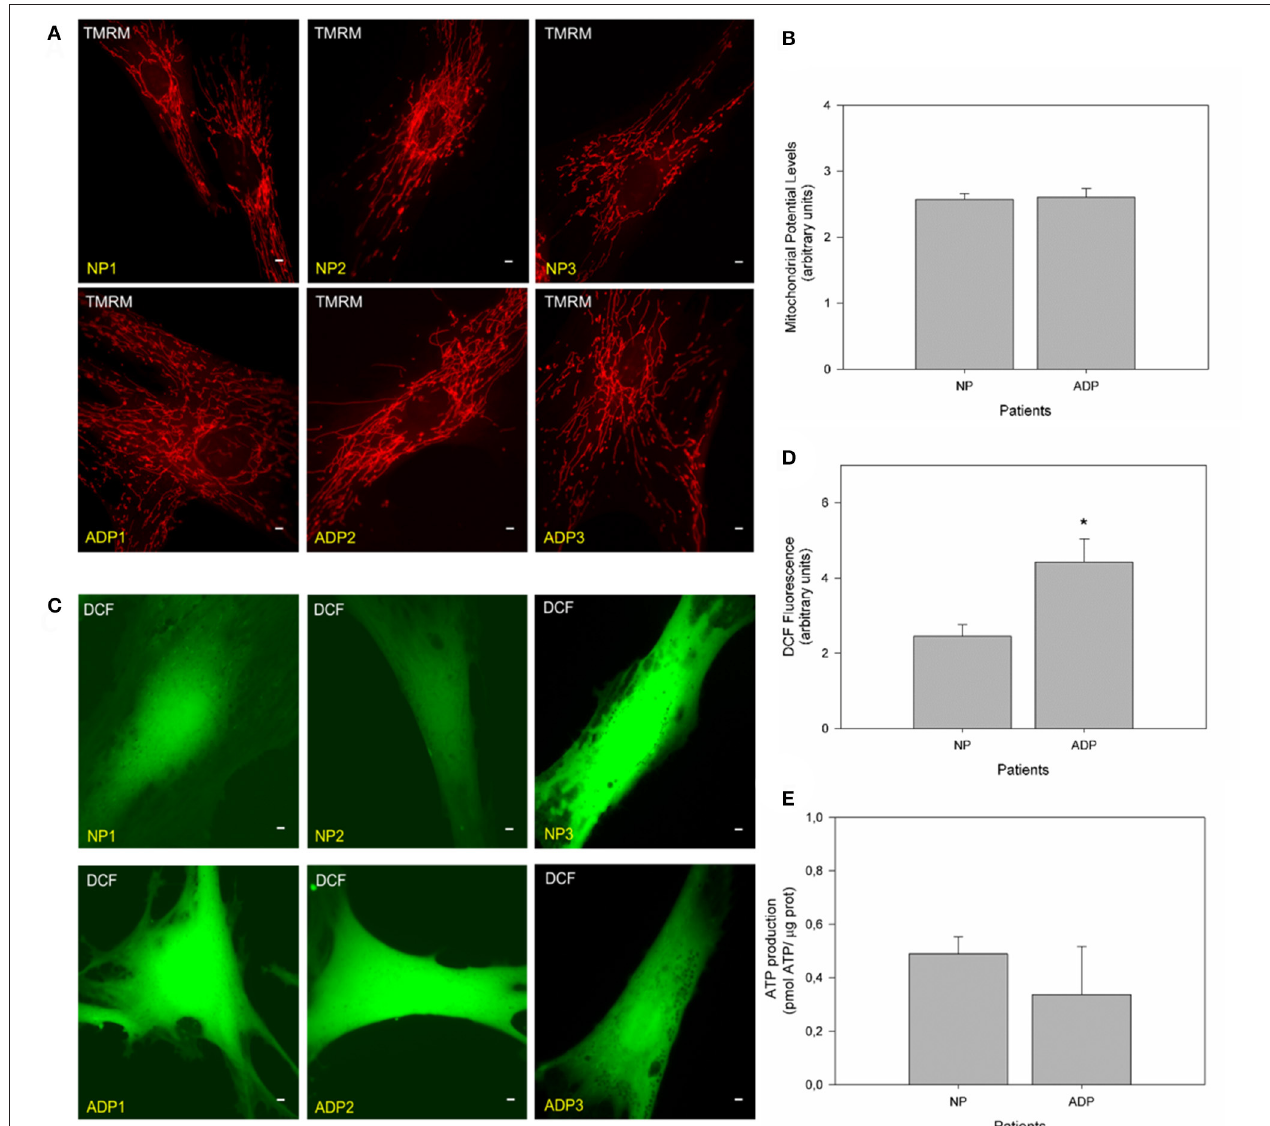
FIGURE 3 | Fibroblasts of AD patients showed an increase in reactive oxygen species (ROS). (A) Representative fluorescent images of TMRM show mitochondrial membrane potential levels in fibroblasts of control and AD patients. Bar = 10 µ m. (B) The graph represents a quantitate data of mitochondrial potential levels as arbitrary units. Data are mean ± SE, n = 3 (technical replicates for each subject). (C) Representative fluorescent images of DCF intensity. Bar = 10 µ m. (D) Graph shows quantitative data of ROS levels in each patient’s cell type. Data are mean ± SE, n = 3 (technical replicates for each subject). * p < 0.05 indicated differences between groups calculated by Student t -test. (E) The graph shows total ATP levels (pmol) normalized by µ g of protein extracted from control and AD fibroblasts. Data are mean ± SE, n = 3. * p < 0.05 indicate differences between groups calculated by Student t